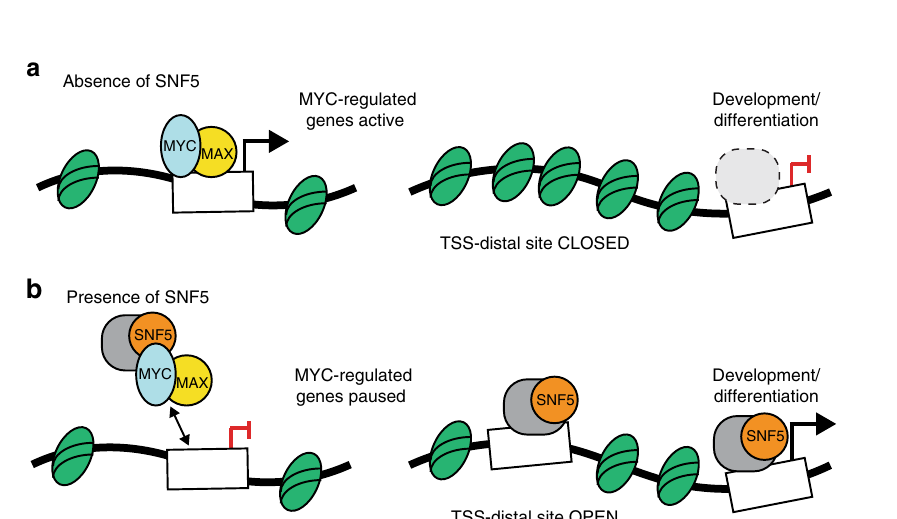
Fig. 4 SNF5 mimics the primary transcriptional effects of MYC inhibition. a Heatmaps displaying log 2 -fold change (Log2FC) of active polymerases (compared to EGFP) in the promoter-proximal region and ±5Kb around the transcription start site (TSS), as determined by PRO-Seq. The two heatmaps are sorted in the same order; genes with increase in both OmoMYC and SNF5, genes with increase in OmoMYC only, and other active genes. Genes in each group are ranked by the OmoMYC FC near the TSS. b Heatmaps of genes showing changes in pausing index for OmoMYC and SNF5, compared to EGFP. Left panel: genes are ranked based on log 2 -fold change of pausing index in OmoMYC, and the corresponding changes in SNF5 are shown on the right side. Right panel: genes are ranked based on log 2 -fold change of pausing index in SNF5, and the corresponding changes in OmoMYC are shown on the right side. c Overlap of unique genes that had a change in pausing index upon OmoMYC expression with those that had a change following expression of SNF5 (FDR < 0.05). d Gene set enrichment analysis showing the distribution of genes that had an induced pause following SNF5 reintroduction against the ranked list of all genes with change in pausing index following OmoMYC expression (FDR < 0.05, genes ranked by log 2 -fold change). e Gene set enrichment analysis, as in d , except for genes that had loss of pause following SNF5 reintroduction. f Overlap of genes that had increased pausing index (induced pause) for both OmoMYC and SNF5 (FDR < 0.0001). g Overlap of genes that had decreased pausing index (pause release) for both OmoMYC and SNF5 (FDR < 0.0001). h Overlap between the number of genes identi fi ed as MYC targets from ChIP-seq analysis (Fig. 3) that also had a resulting